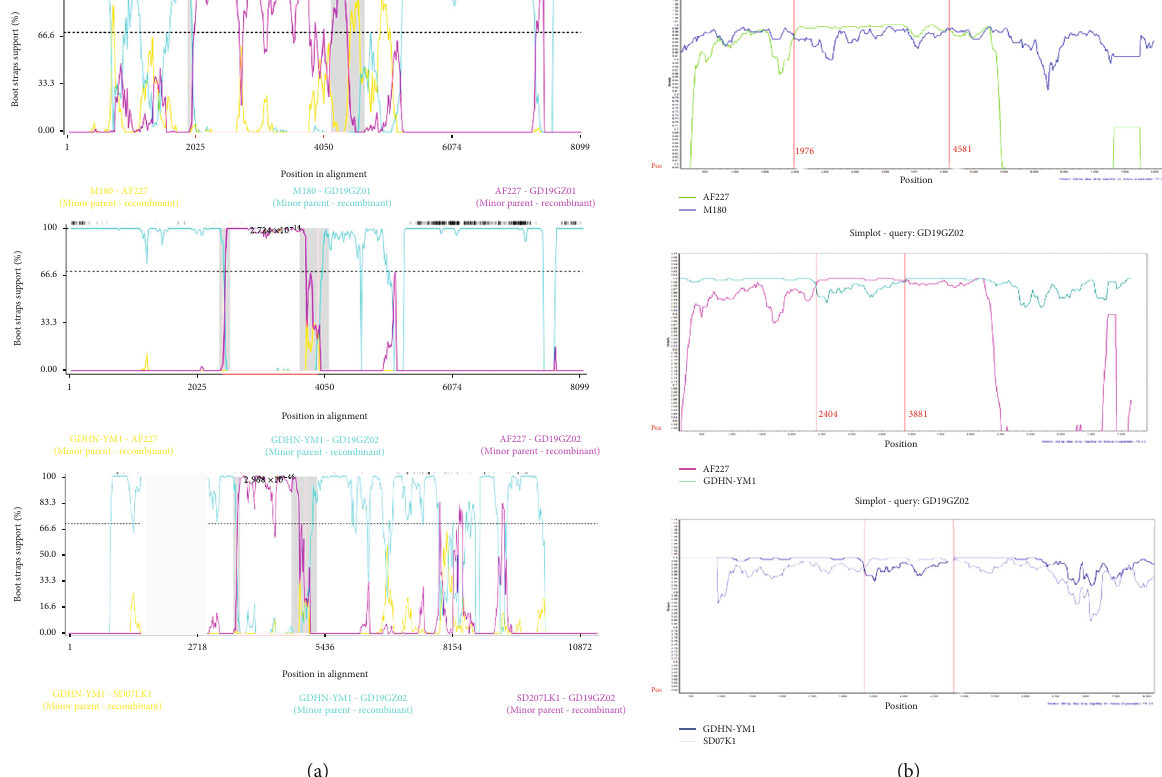
Figure 5: Determination of reorganization events. (a) The PDR5 analyzed the recombination events of the virus isolates. The bootscan was based on the pairwise distance model, with a window size of 200, a step size of 50, and 1000 bootstrap replicates generated by the RDP5. (b) The SimPlot analysis graph of reorganized breakpoints. These were based on a 200-bp window; each step is 20bp for comparison (100 self- expanding, setting a 90% consistent tree, neighbor-joining method, Kimura two-parameter